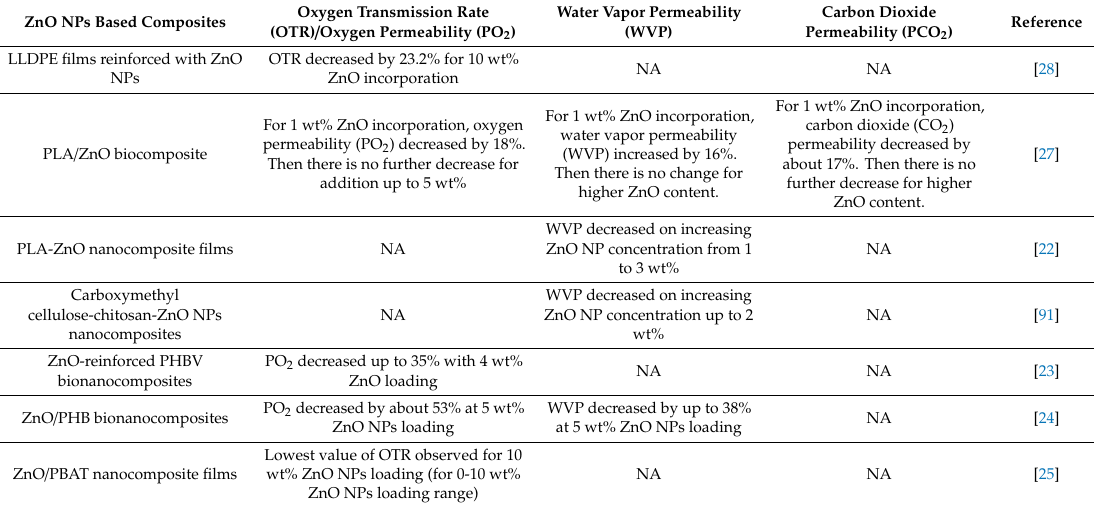
Table 4. Barrier properties of ZnO NPs based (bio)polymer